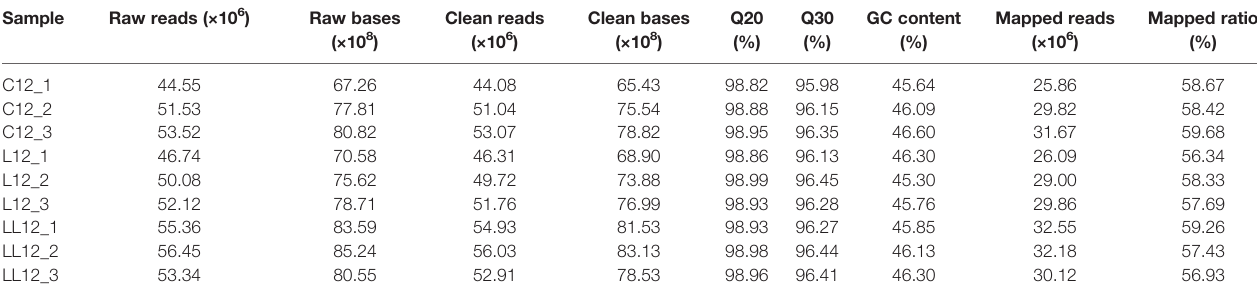
TABLE 1 | Summary of the transcriptome assembly.